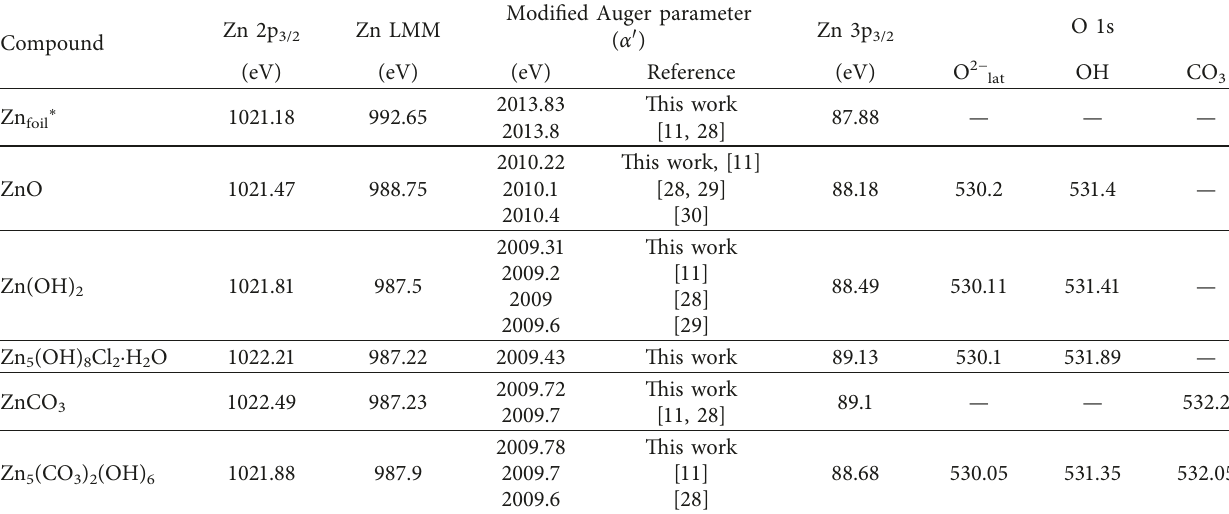
Table 2: Binding and kinetic energies for selected photoelectrons and Auger electrons estimated on the basis of experimental spectra for